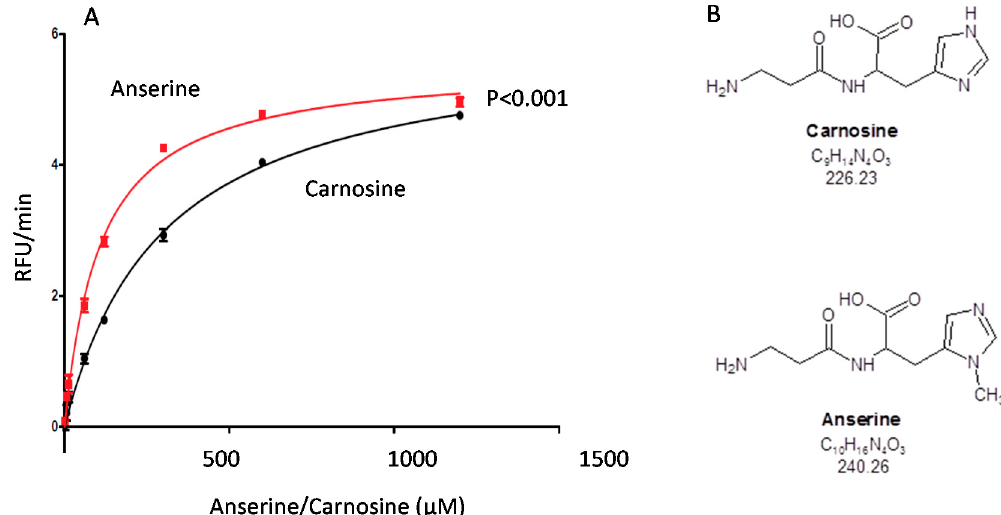
Figure 4. Antioxidant capacity of carnosine and anserine. ( A ) Antioxidant capacity of anserine and carnosine were assessed by a standardized oxygen radical absorbance capacity (ORAC) assay. Antioxidant capacity, given as relative fluorescence units (RFU), of anserine (red line) is significantly higher as compared to carnosine (black line). ( B ) Molecular structure of carnosine and its methylated derivate anserine.